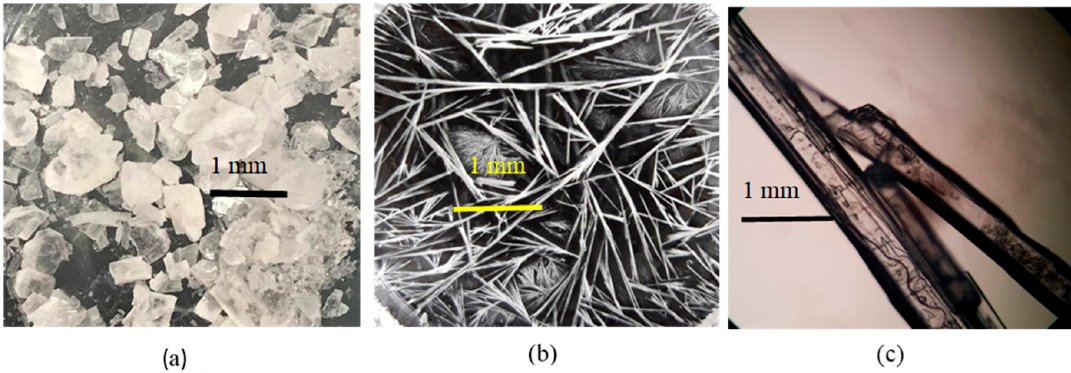
Figure 2. Crystal morphology under a binocular microscope of ( a ) diclofenac sodium hydrate (NDH), ( b ) L-proline (LP), and ( c ) diclofenac–sodium–proline cocrystal (NDP). All recrystallizations were used ethanol solvent 95% under ambient conditions (72 ± 2% RH/25 ± 2 °C).